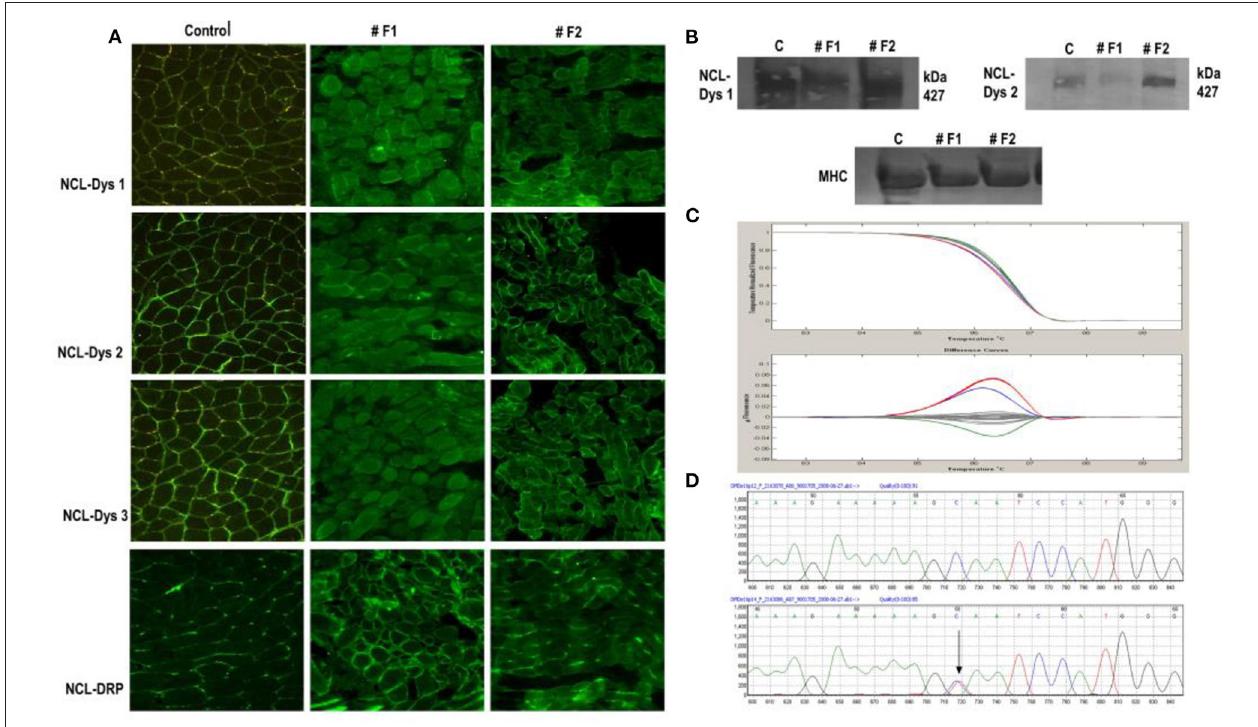
FIGURE 2 | Immunofluorescent staining of dystrophin in normal control muscle and twin sisters (#F1 and #F2). (A) Immunostaining for dystrophin with antibodies against all three dystrophin domains for twin sisters revealed a difference between them. The first sister (F1) shows a reduction/ discontinuous signal for dystrophin and overexpression of utrophin from NMJ to the whole sarcolemma while the other sister (F2) presented only a slight reduction of signal for dystrophin. Scale bar 50, µ m. (B) Dystrophin WB analysis of muscle biopsy sample from both sisters revealed the same difference between sisters with reduced intensity of bands for dystrophin with (a) antibody directed against the dystrophin rod domain (DYS1) and (b) antibody directed against the dystrophin C-terminal (DYS2) for sister F1 and an almost normal expression for sister F2 compared with control muscle sample. (C) HRM analysis revealed the same sequence variant for both sisters in exon 16 in the DMD gene (red line). Also, patient #18 was identified with a variation in exon 16 (blue line) compared with normal (Gray lines). (D) A section of the sequencing electropherogram for one twin compared with control.